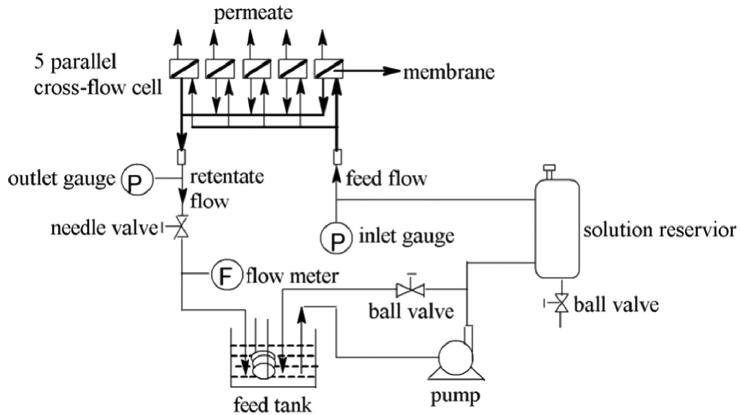
Figure 2. Setup schematic drawing for evaluation of RO performance for the membrane.